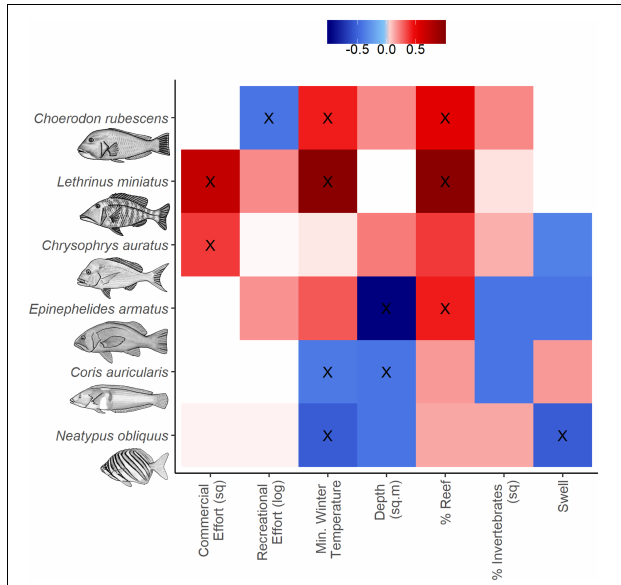
FIGURE 3 | Variable importance scores from full subsets GAM analyses to predict the abundance distribution of the species of interest. Positive (red), zero (white) and negative (blue) relationships with response variables are indicated and variables within the most parsimonious model for each taxa are indicated (X, see Table 2